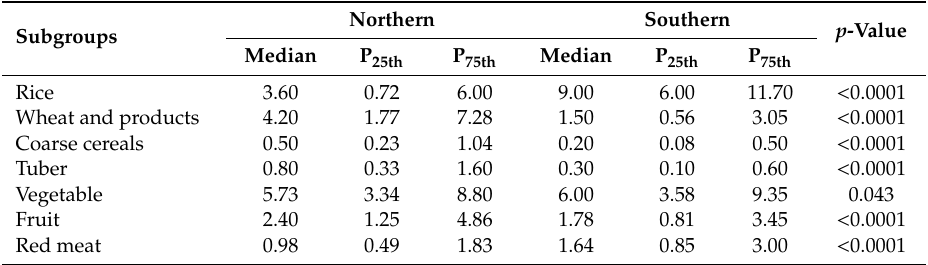
Table 3. Baseline characteristics of monthly food consumption by regions (kg / month).